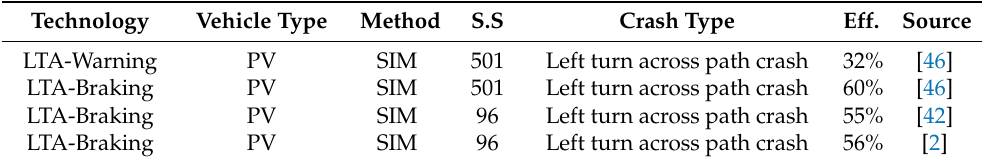
Table 6. Evidence for the crash avoidance effectiveness of